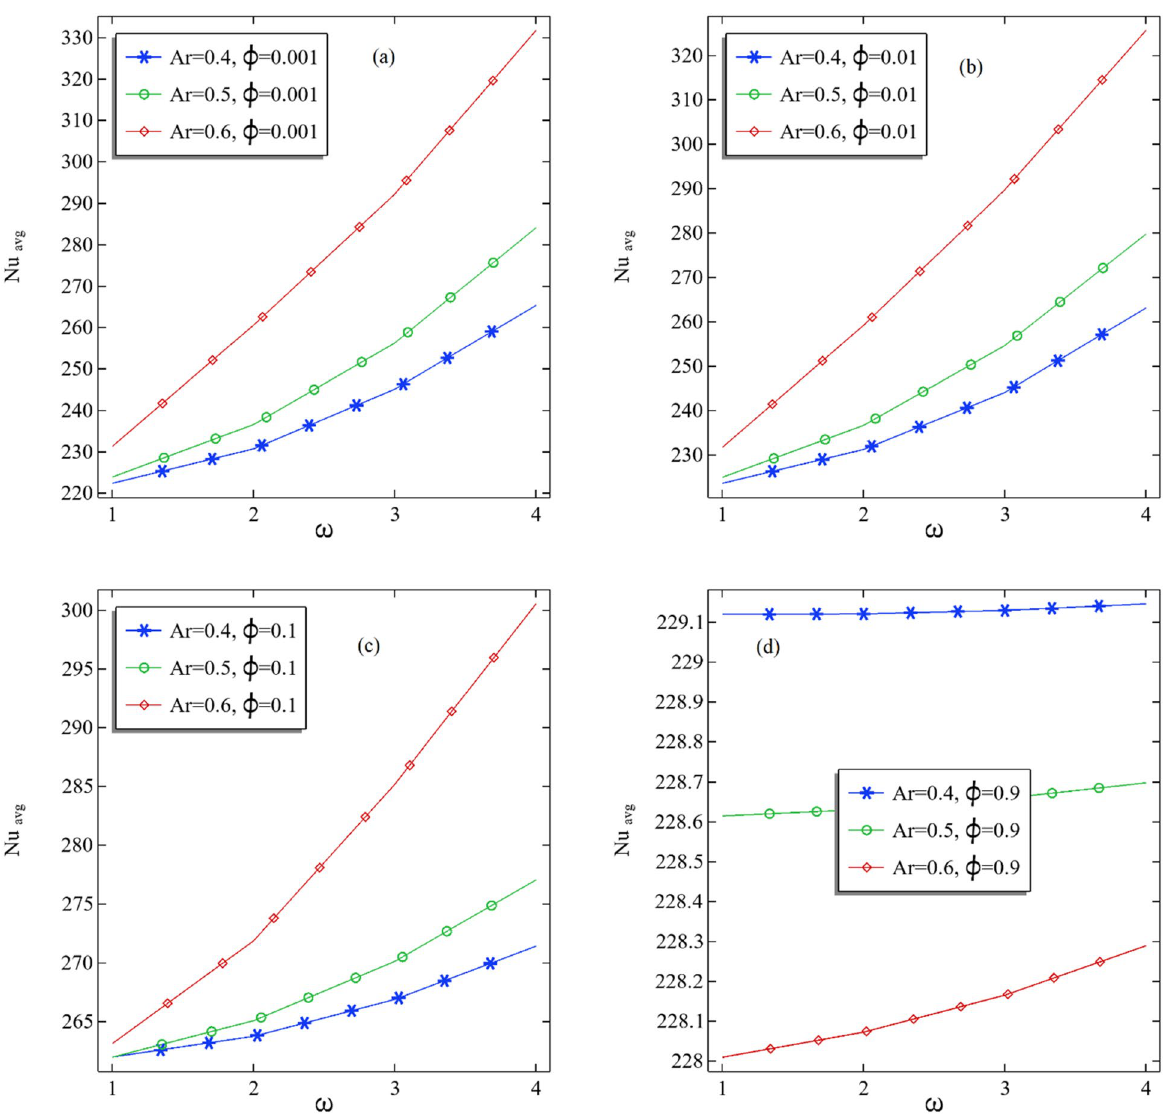
Figure 7. ( a – d ) The average Nusselt number at the middle plane with the increasing rotation rate of the inner